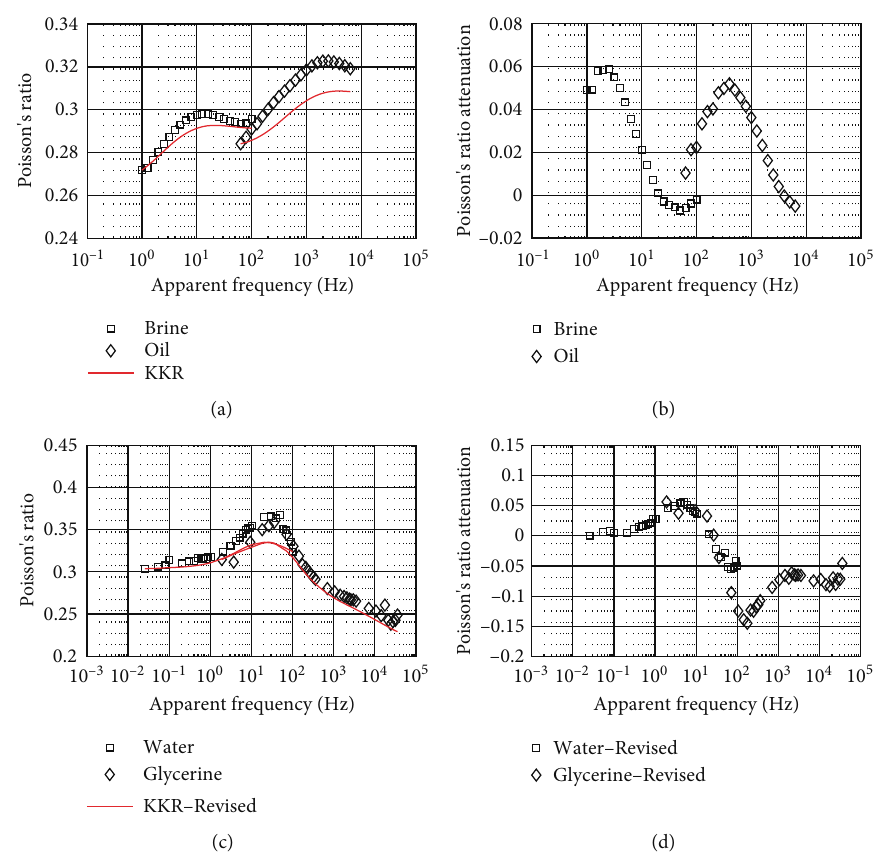
Figure 7: The frequency dependence of Poisson ’ s ratio and it associated attenuation of fl uid-saturated sandstone samples (from Sun et al. [17] and Pimienta et al. [20],